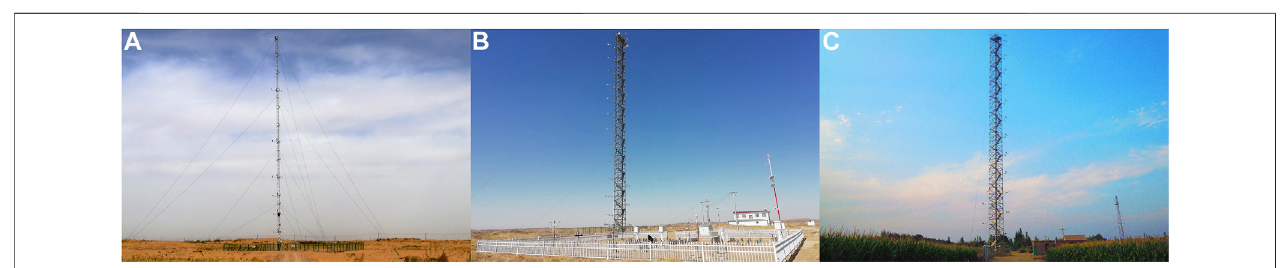
FIGURE 2 | Map of three landscapes in the northeastern Ulan Buh Desert. (A) Desert area, (B) Desert-oasis ecotone, and (C) Oasis.